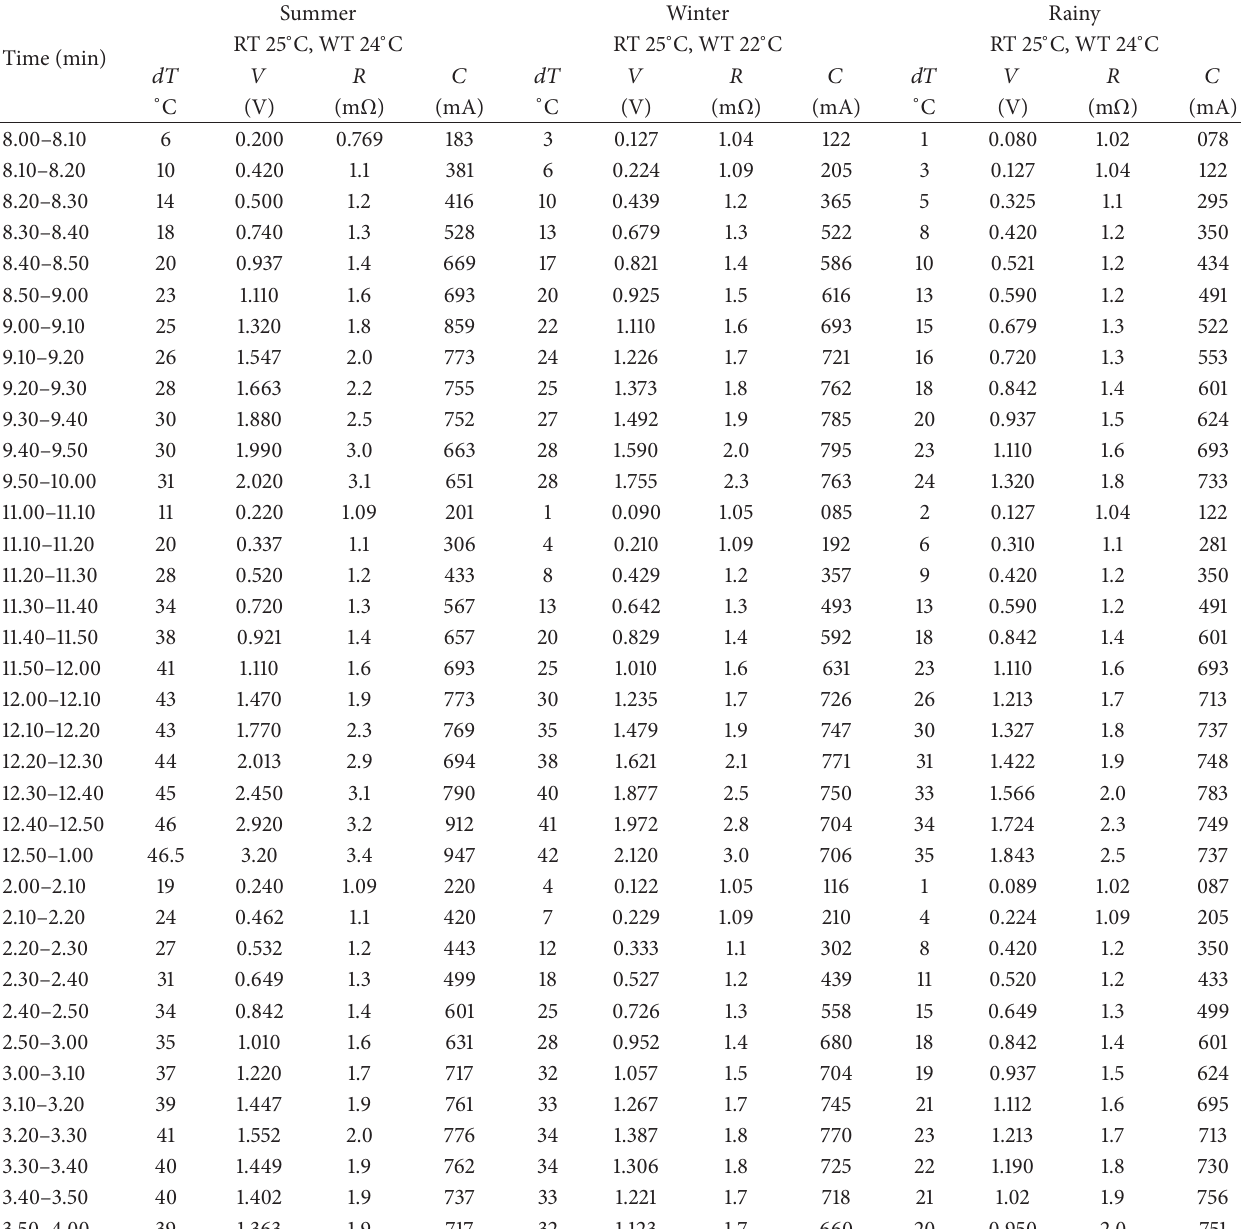
Table 1: Thermoelectric data of different